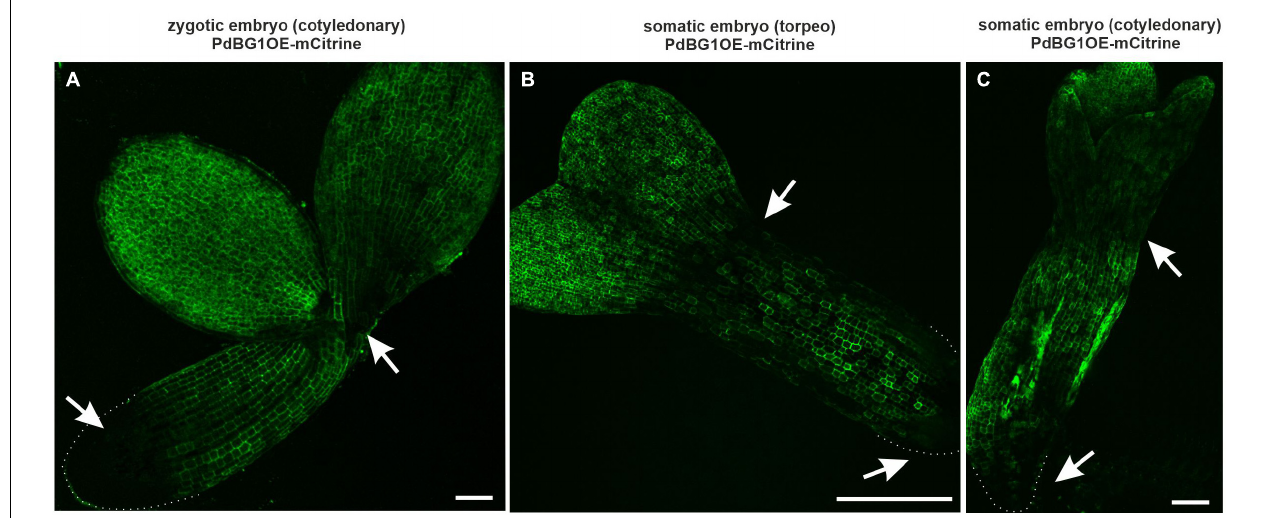
FIGURE 5 | PDGB1 distribution in ZEs and SEs. (A) ZE in the cotyledonary stage. (B) SE in torpedo and (C) in cotyledonary stage. Arrows indicated the areas with lower PDGB1. Dotted lines indicate the embryo root surface. All images are from CLSM. Scale bars; (A) = 50 µ m; (B,C) = 100 µ m.